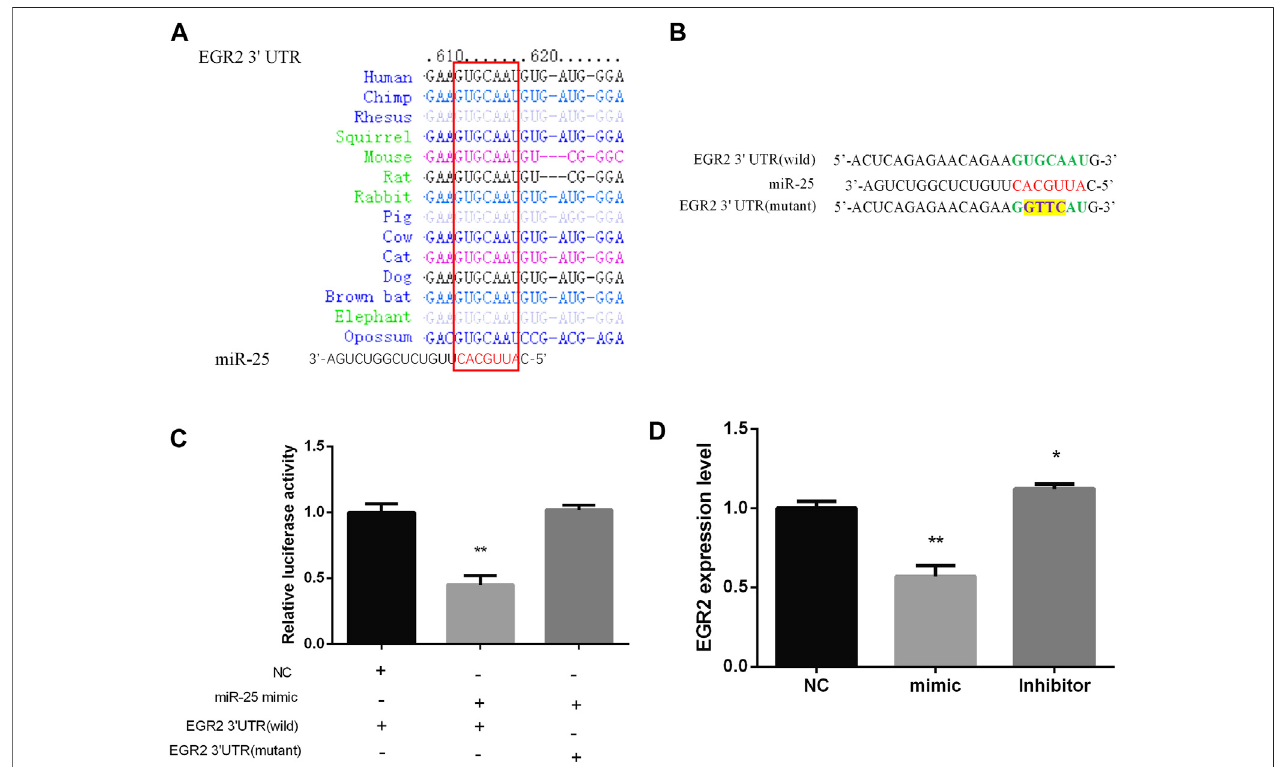
FIGURE5| EGR2isatargetgeneofmiR-25. (A) miR-25ishighlyconservedinvariousspecies. (B) Dual-luciferasereportervectorscontainingthe3 ′ UTRsequenceofEGR2 gene (wild type and mutant type), respectively. (C) Luciferase activity analysis was detected after co-transfection miR-25 and dual-luciferase reporter vectors into cell. (D) EGR2 mRNA level was detected after gain or loss miR-25. Value in graphs represents means ± SD. At least three independent experiments were carried out. ** p < 0.01; * p <